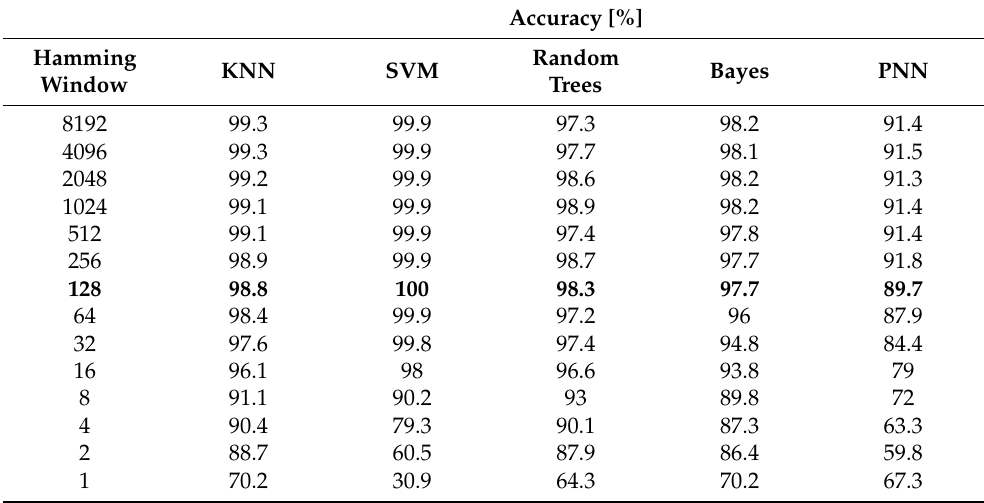
Table 1. Initial analysis of the spectrum of the recorded AE signals from PD executed for different widths of the Hamming window for various classifiers and ten-fold cross-validation.